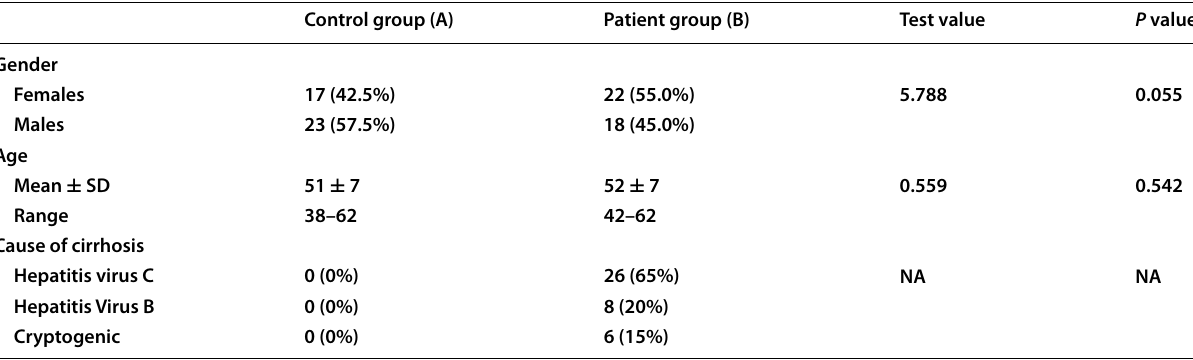
Table 1 Demographic data in patients and